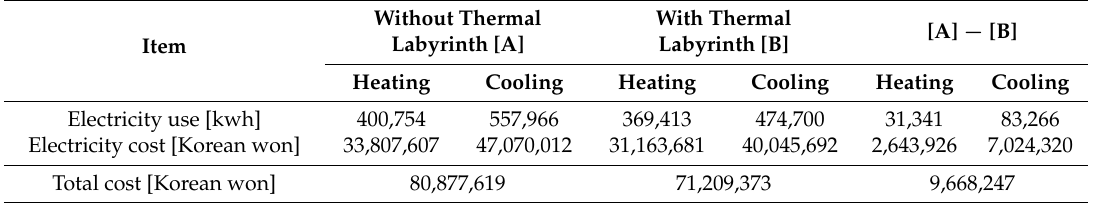
Table 12. Reduction in the annual energy costs.